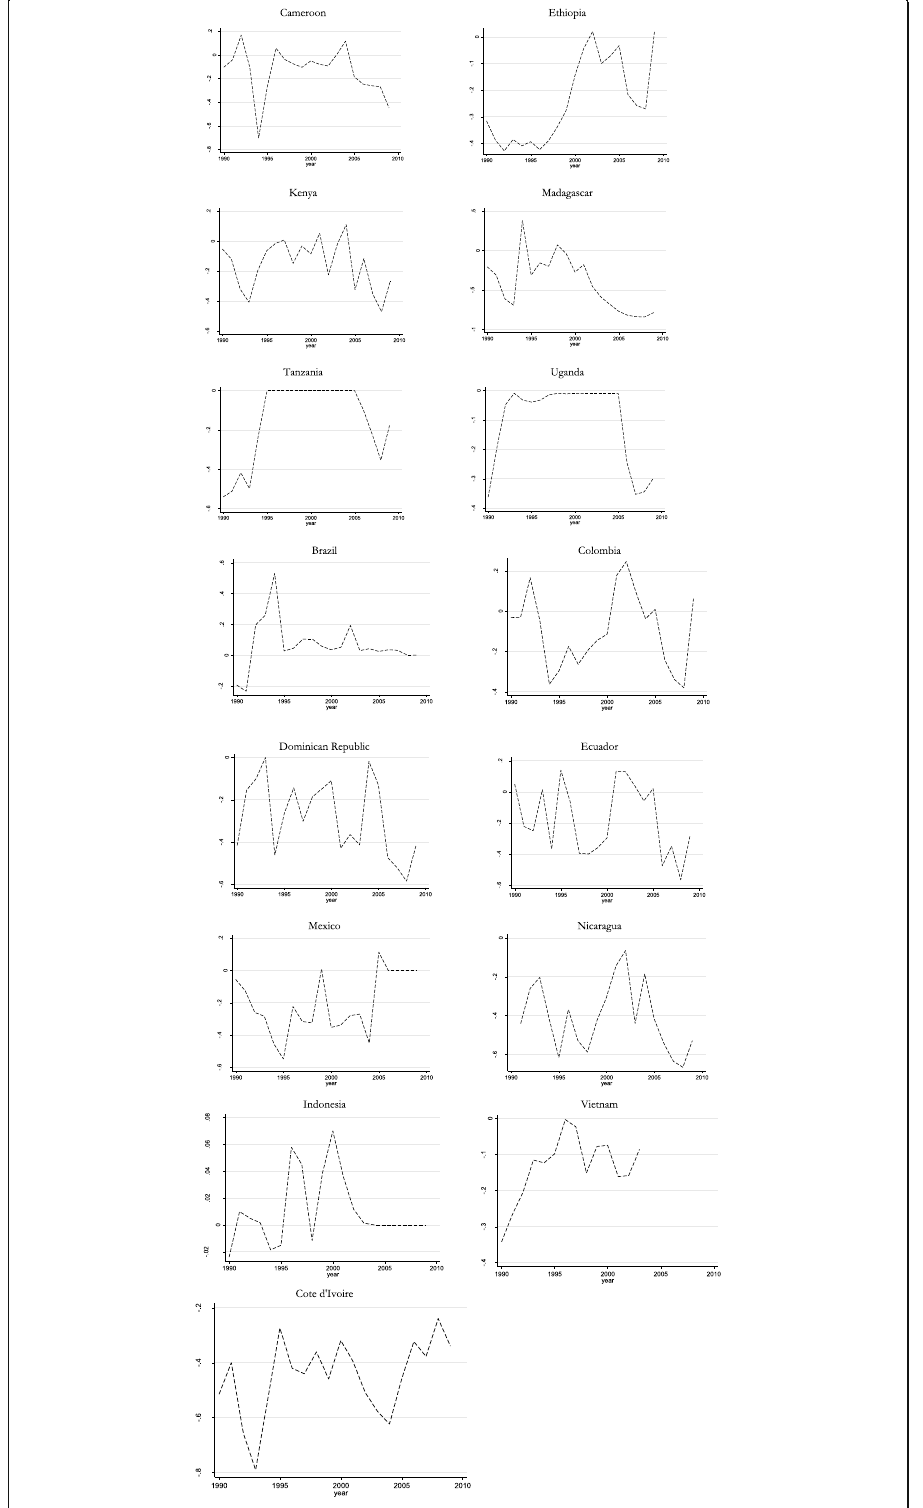
Fig. 2 Graphical trend of NRA for coffee-producing